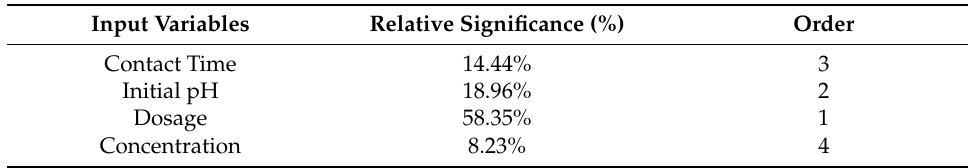
Figure 21. A backpropagation artificial neural network schematic diagram.